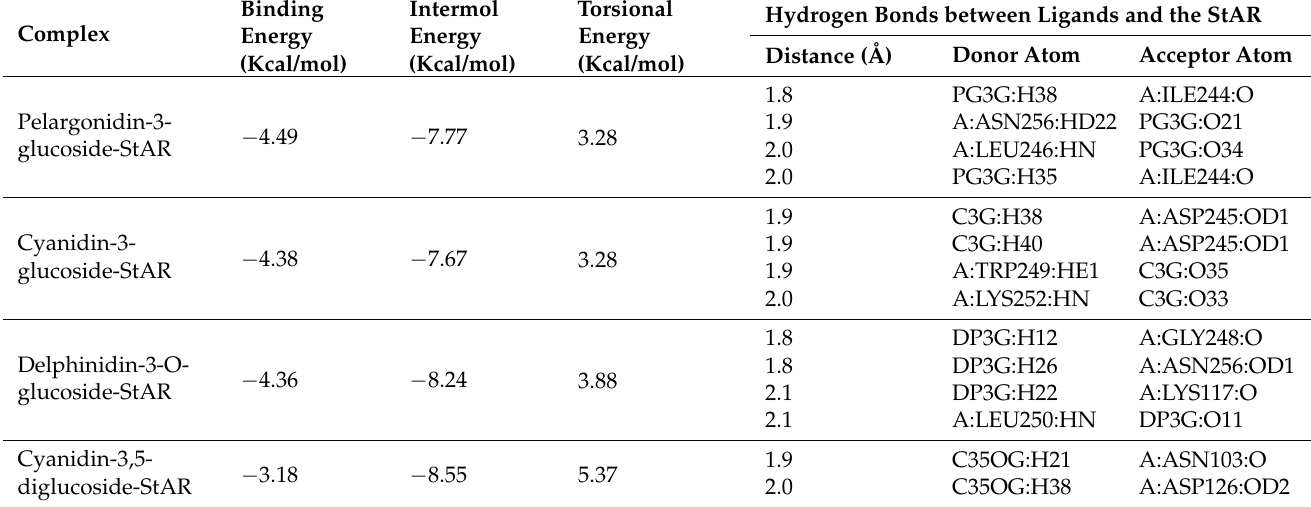
Table 1. Binding energy and sites between four anthocyanins and StAR based on molecular